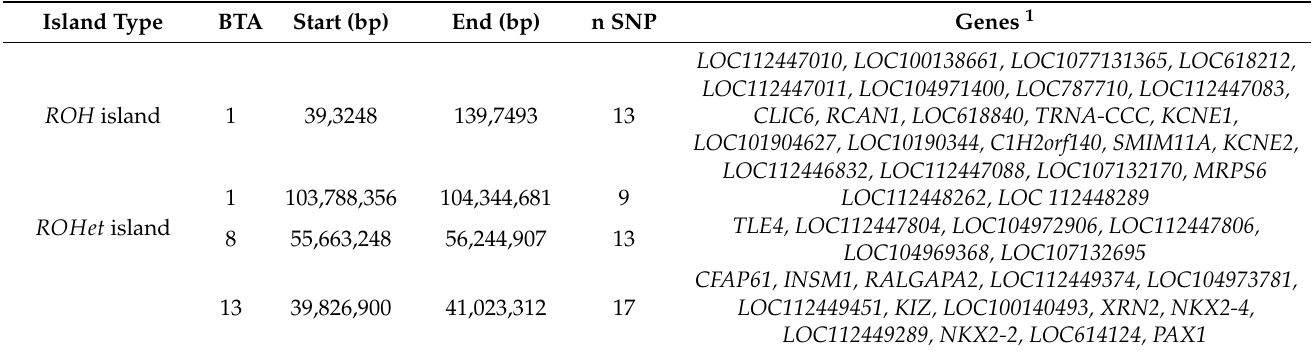
Table 5. Description of the runs of homozygosity ( ROH ) and heterozygosity ( ROHet ) islands found in the Mexican Romosinuano beef cattle population’s autosomal genome.